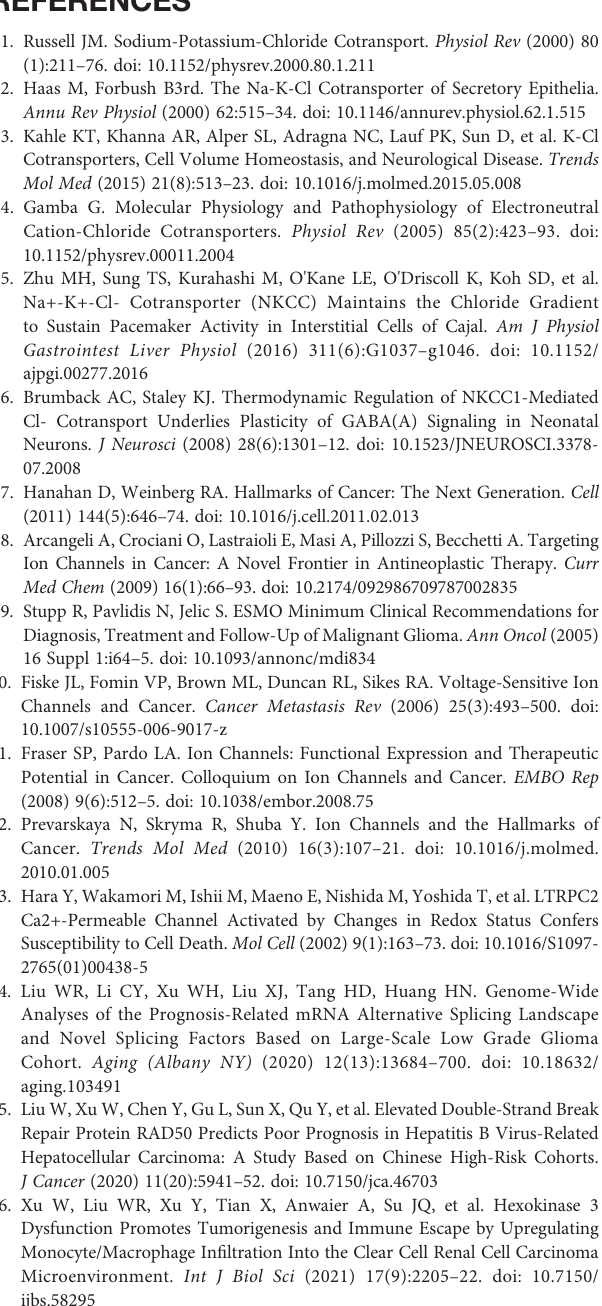
expression and transcriptional expression of KCC2 and NKCC1. (B) The effect of CNV expression and KCC2 and NKCC1 on the survival of pan-cancer patients. Supplementary Figure 2 | KCC2 mutations in 48,834 pan-cancer from 166 independent studies. (A) In pan-cancer, the somatic mutation frequency of KCC2 mutation and the main mutation site (somatic mutation frequency:1.96%). (B) Frequency of change of KCC2 in pan-cancer. (C) Survival difference between the KCC2 MUT and KCC2 WT group in pan-cancer using K-M